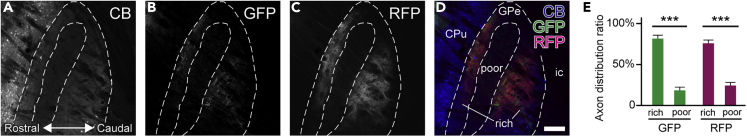
Overlap Distribution of CB Immunoreactivity and MSN Axon Fibers in the GPe(A–D) Distributions of CB, GFP, and RFP immunoreactivities in the GPe. One week after AAV vector injections into the CPu of Drd1-Cre mice, brain sections were immunostained for CB, GFP, and RFP. The GPe can be divided into two regions—CB-rich and CB-poor—according to the immunoreactivity for CB. Scale bar: 100 μm.(E) The total immunofluorescence intensities of GFP and RFP in CB-rich and CB-poor regions were normalized to 1 arbitrary unit in each mouse, and the respective percentages were calculated. Data are represented as mean ± SD. A significant difference was detected between the two regions in both GFP and RFP (Tukey's post hoc test; ∗∗∗p < 0.001; n = 3 mice).